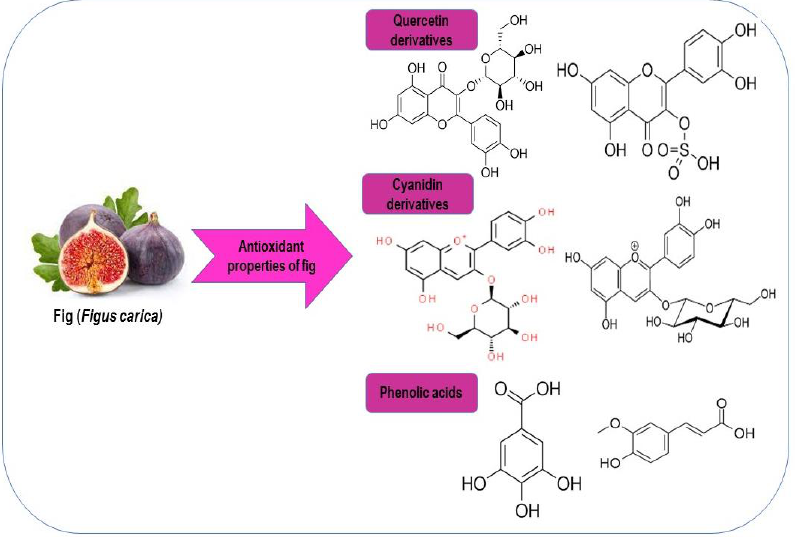
Figure 2. Antioxidants properties of fig.